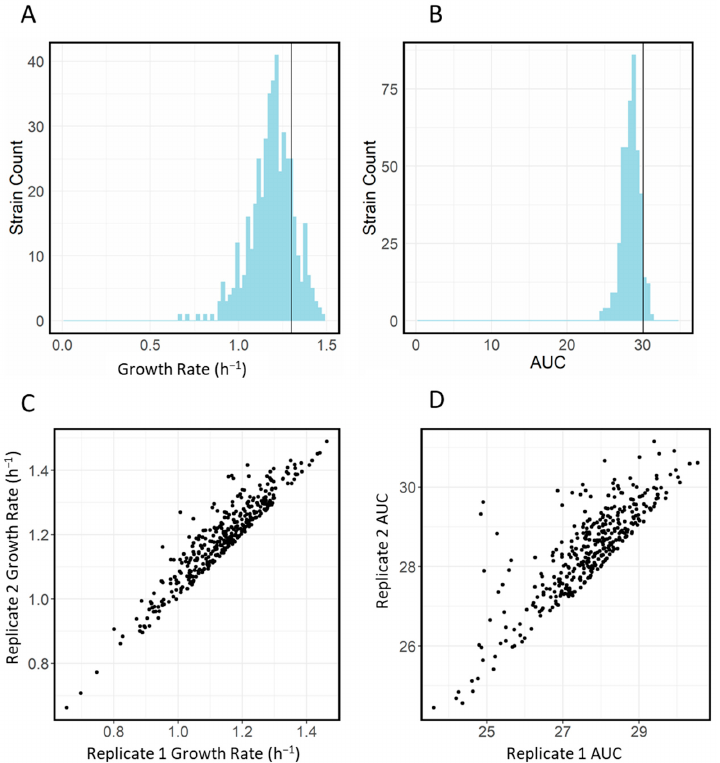
Figure 1. Histograms illustrating distributions of ( A ) growth rate and ( B ) area under the curve (AUC) for transporter library growth in LB in the absence of antibiotics. Scatter plots showing correlation between replicates for ( C ) growth rates and ( D ) AUC for transporter library growth in LB alone. Compared to growth in LB, we saw a much larger degree of variation in growth in the presence of the antimicrobial compounds, consistent with multiple transporter knock- outs influencing the level of intracellular antibiotic accumulation. Figure 2A shows rank- order curves for the mean AUC for growth of the transporter library in LB, while Figure 2B–D shows the same information for growth in the indicated antibiotics. In the presence of antibiotics, the rank-order curves show a much wider spread of values. Figure 3 shows a box and whisker plot illustrating the distribution of AUC values for all compounds tested.